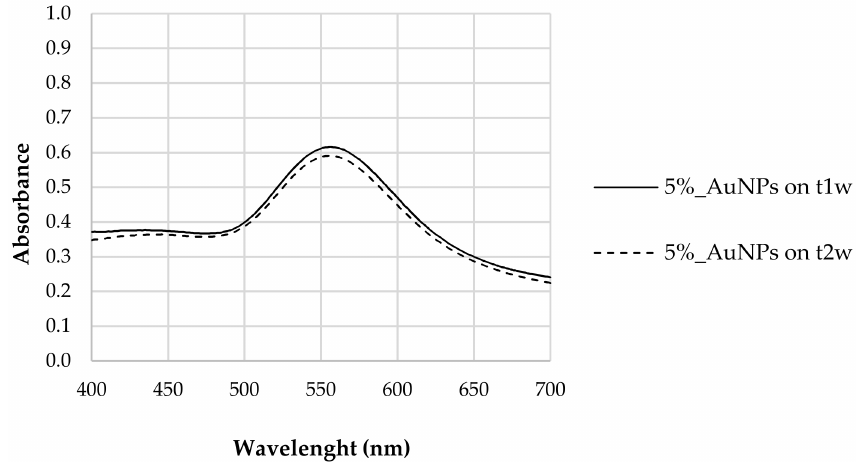
Figure 1. LSPR of AuNP samples synthesized with 5% tea extract ( Thea sinensis ) at t 1w (after 1 week) and t 2w (after 2